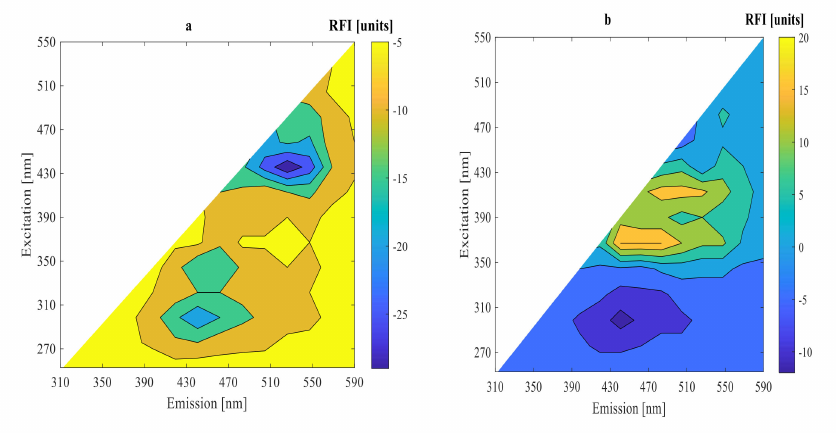
Figure 6. Subtracted spectra of the initial one from the original spectra after ( a ) 9 h and ( b ) 15 h fermentation of 4 g/100 mL substrate inoculated with mixed strains of Lactiplantibacillusplantarum A6 and Lacticaseibacillusrhamnosus